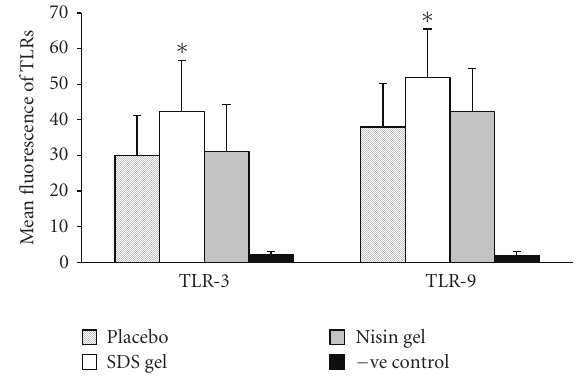
Figure 2: Flow cytometric analysis of TLR expression in rabbit CVE cells after intravaginal administration of placebo, nisin (15.15mM in 2mL of 1% polycarbophil gel) SDS (56 μ M in 2 mL of 1% polycarbophil gel) and 2 mL of 1% polycarbophil gel. Mean fluorescence intensity for TLR-3 and 9 were significantly increased in SDS gel-treated animals compared to their respective placebo and nisin gel-treated groups. The mean and error bars indicate standard deviation of triplicate measurements obtained from three separate experiments.